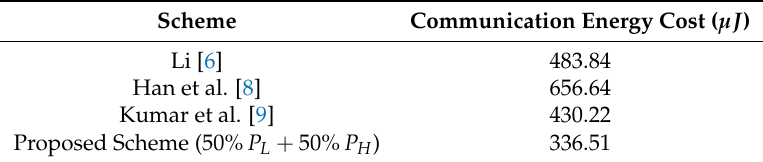
Table 5. Comparison of communication energy